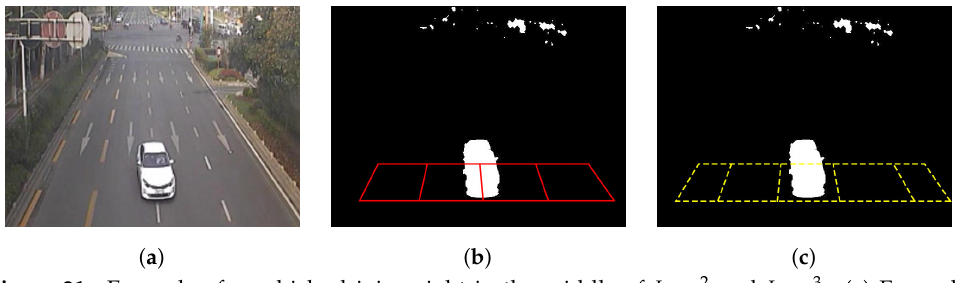
Figure 21. Example of a vehicle driving right in the middle of Lane 2 and Lane 3 . ( a ) Example frame under RGB mode. ( b ) Detection result set with primary loops. ( c ) Detection result set with secondary loops. Table 19. Example of a vehicle driving right in the middle of Lane 2 and Lane 3